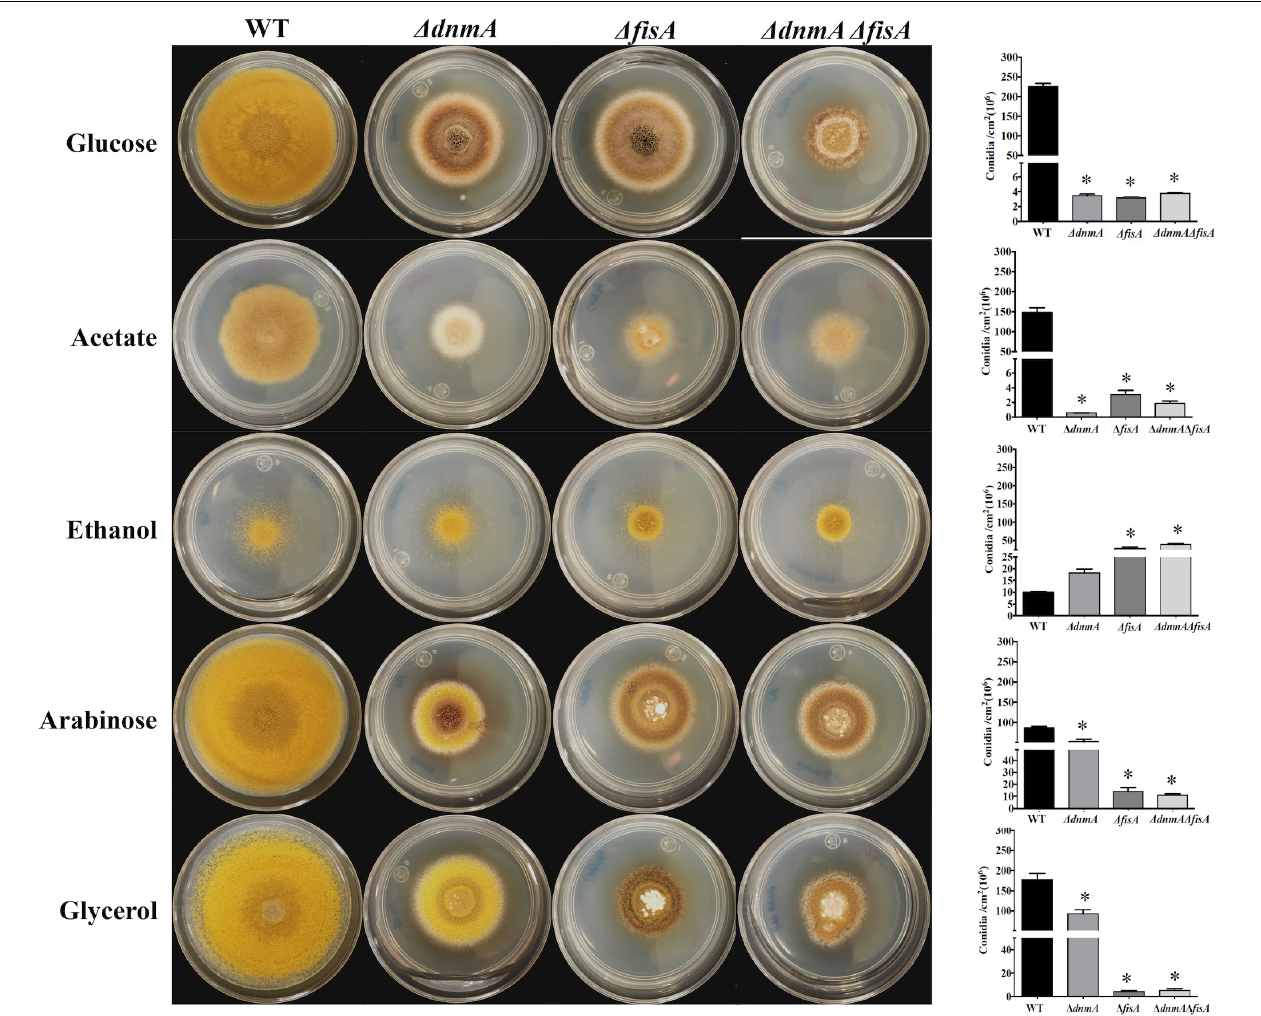
FIGURE 7 | Growth and conidiation of mitochondrial fission mutants are differentially affected by different carbon sources. Conidia (1 × 10 4 ) from strains TRV1 (WT), CVG1 ( (cid:49) dnmA ), CVG2 ( (cid:49) fisA ), and CVG3 ( (cid:49) dnmA (cid:49) fisA ) were inoculated on supplemented MM plates with the indicated carbon sources and incubated at 37 ◦ C for 3 days (Left) and conidiation was quantitated (Right) . Bars indicate standard deviation from three independent experiments. Data analyzed by one-way ANOVA, following Tukey’s test ( ∗ p < 0.05). Asterisks indicate significant differences with respect to the WT